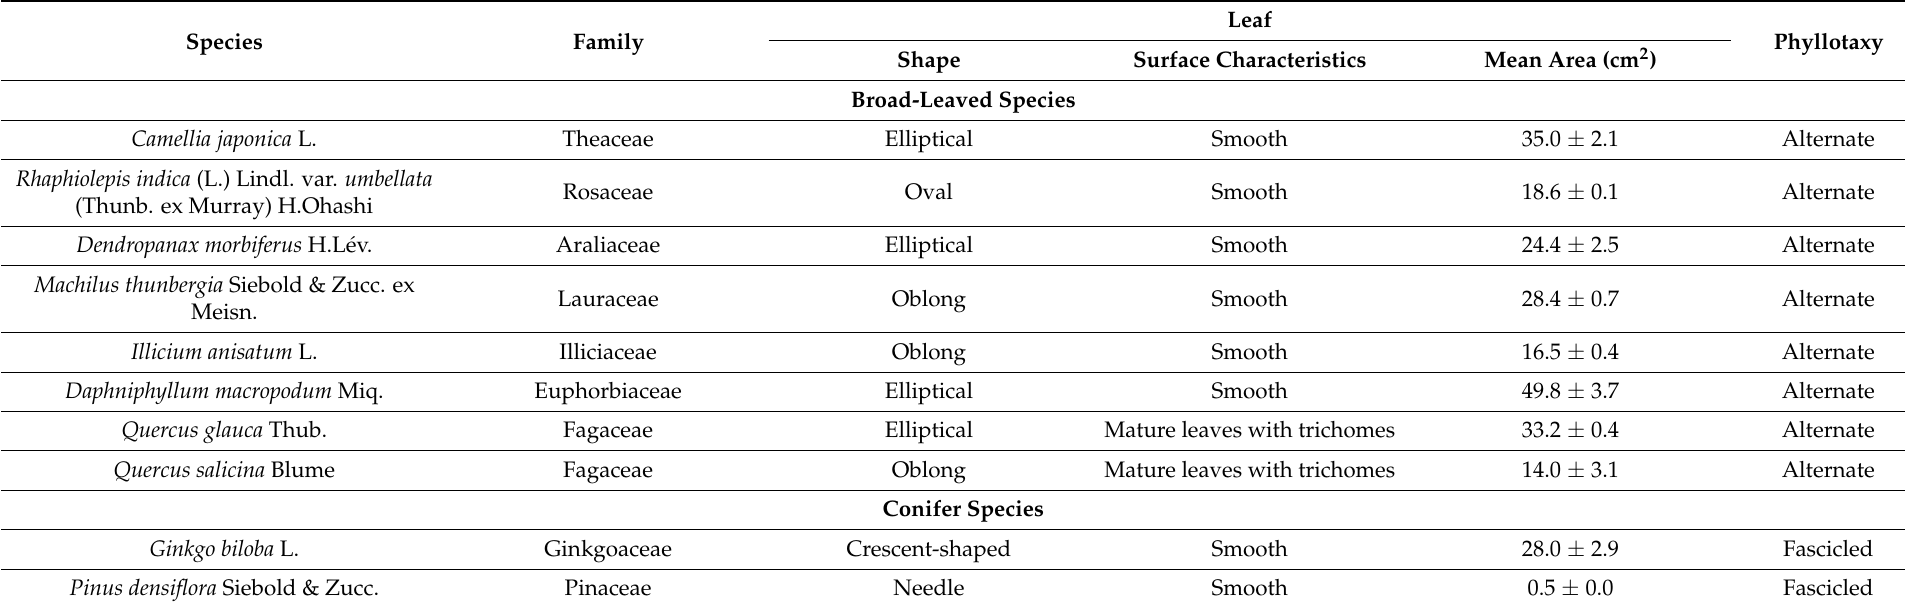
Table 1. Habit, shape, surface characteristics, mean area, and phyllotaxy of leaves studied in this